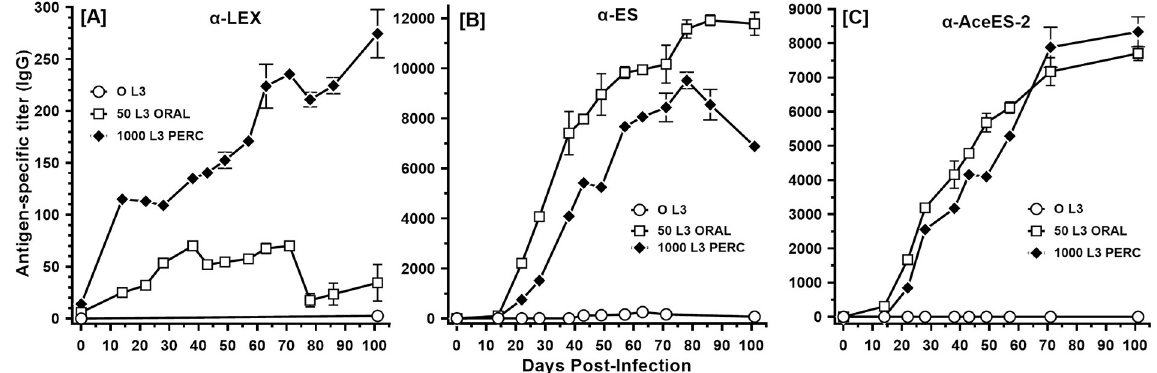
Fig 6. Hookworm-specific antibody responses following percutaneous infection (Experiment 3). Hamsters (n = 6 each group) were infected with the indicated number of L3 by oral or percutaneous route. Specific IgG titers against soluble larval extract (LEX) in pooled hamster sera are presented in [A], titers against adult worm excretory-secretory (ES) antigens are presented in [B], and rAceES-2-specific titers in [C]. Data points represent Mean +/- SD.